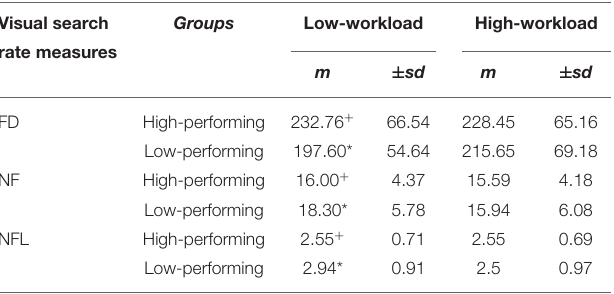
TABLE 2 | m and ± sd of visual search